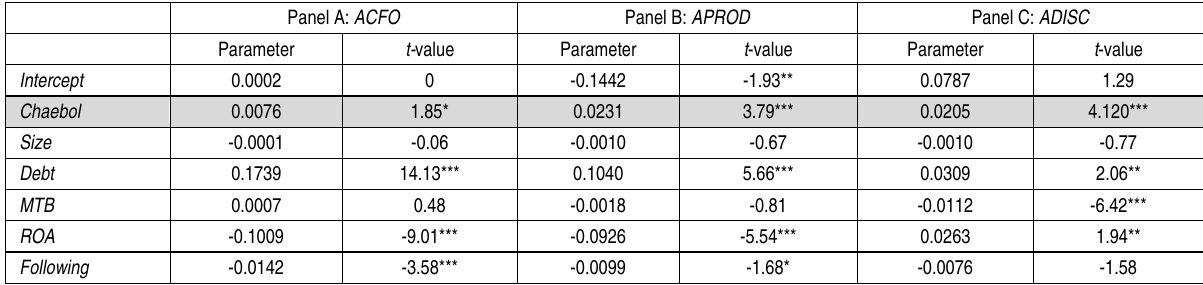
Table 3. The relation between real-based earnings management measures and chaebol firms Panel A: ACFO Panel B: